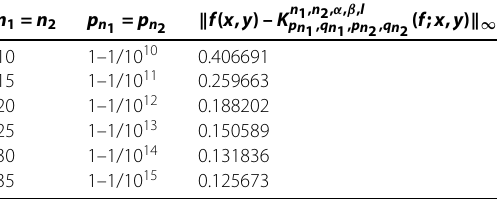
Table 3 The errors of the approximation of K n 1 , n 2 , α , β , l p α = 3, β = 2 and different values of p n